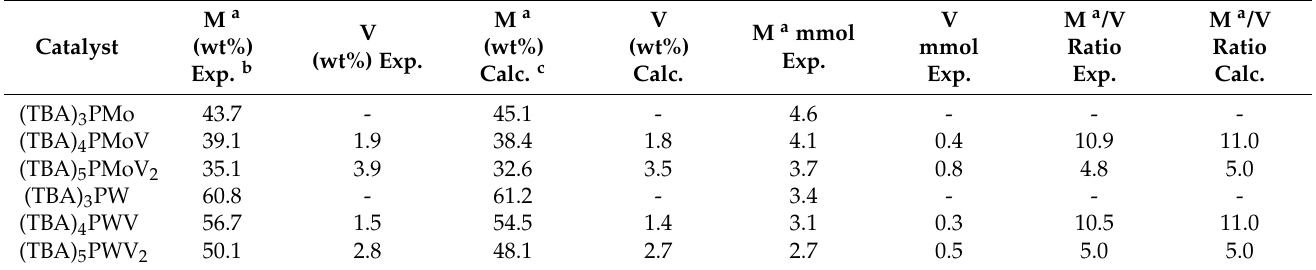
Table A1. Metal analysis of pure and substituted Mo and W catalysts determined by ICP-MS.